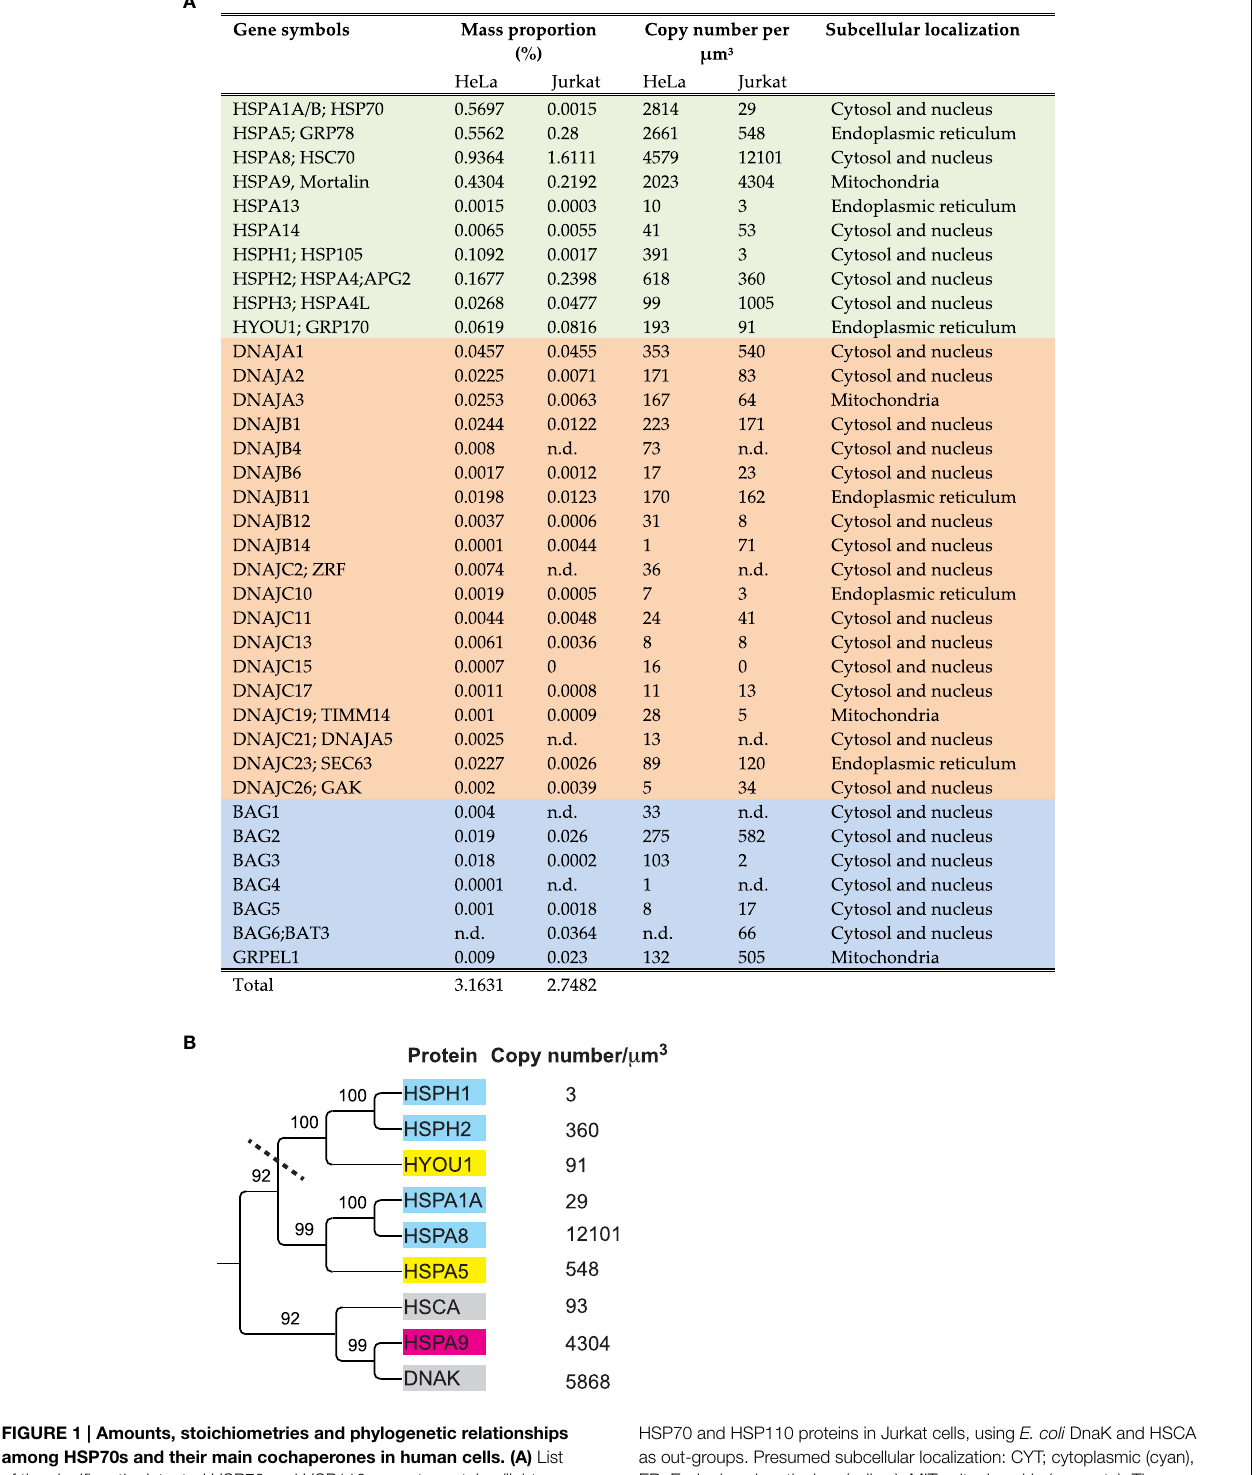
FIGURE 1 | Amounts, stoichiometries and phylogenetic relationships among HSP70s and their main cochaperones in human cells. (A) List of the significantly detected HSP70 and HSP110 cognate proteins (light green), J-domain cochaperones (orange) and NEFs (blue) in Hela and Jurkat cells and their presumed sub-cellular compartments. (B) Phylogenetic tree (neighbor joining method) from the protein sequences of the most abundant